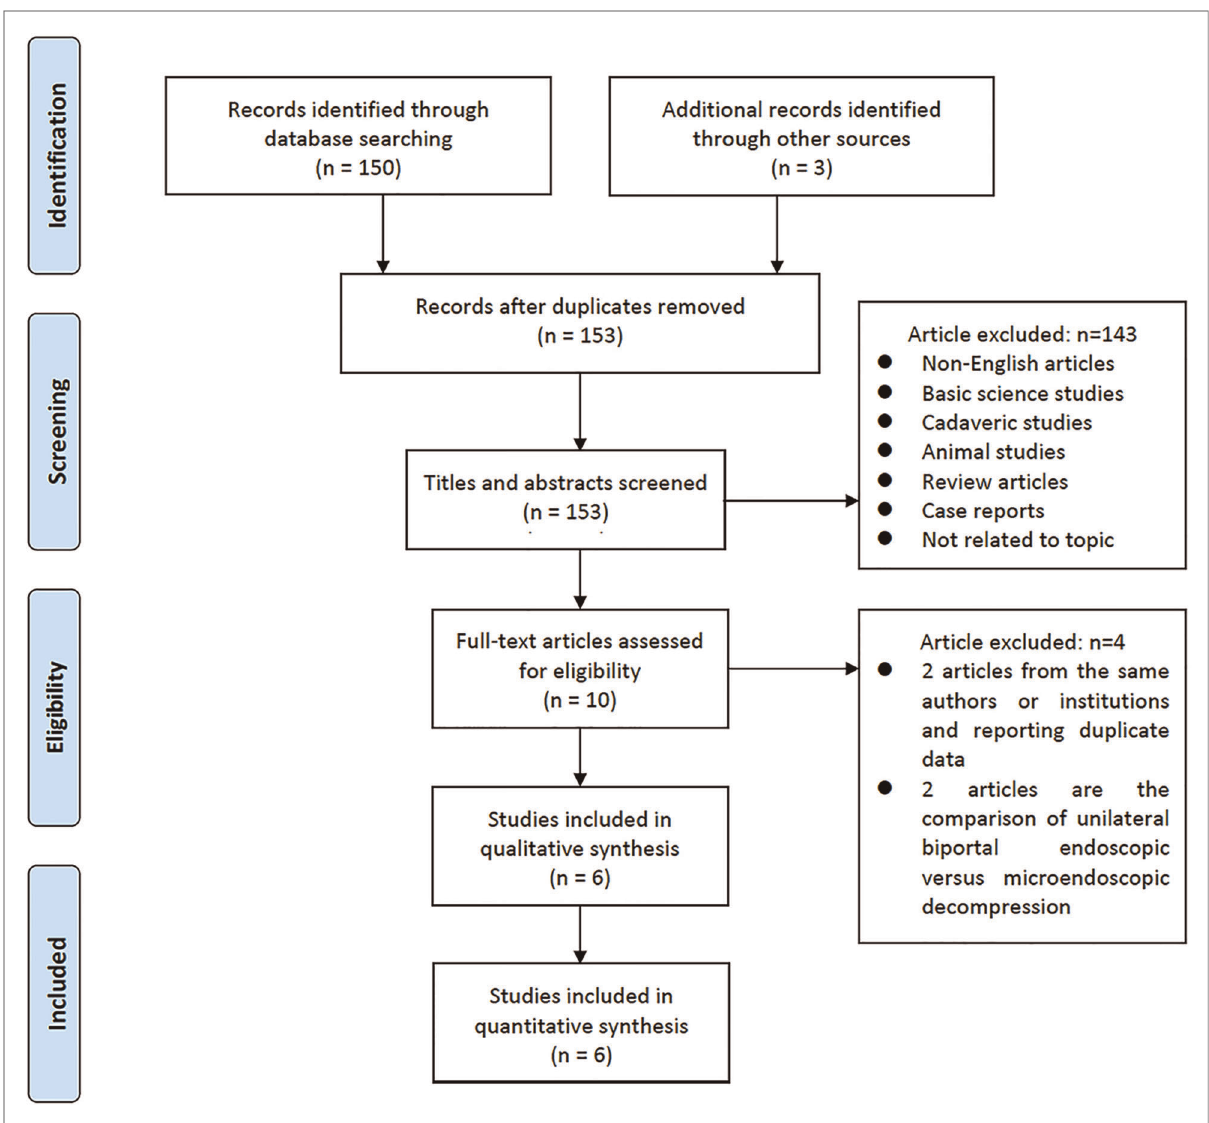
FIGURE 4 Study selection fl ow diagram for the